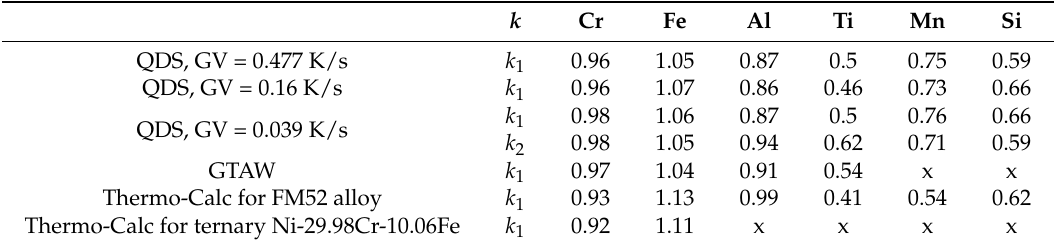
Table 4. Partition coefficients QDS, GTAW, and Thermo-Calc